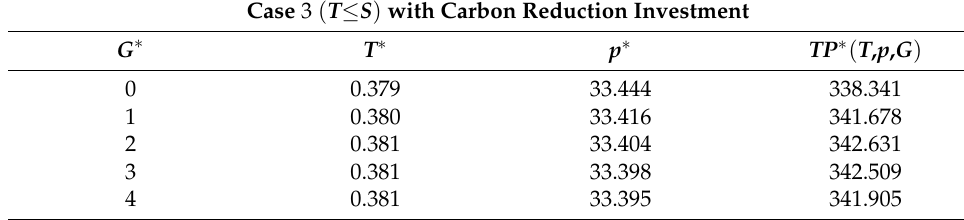
Table 3. Solution algorithm for case 3 to find G ∗